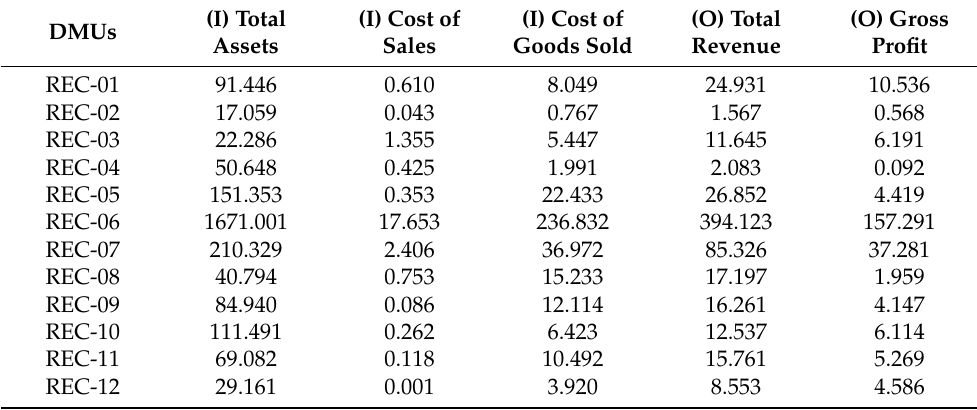
Table A4. The historical data of the year 2018, (unit: million USD).